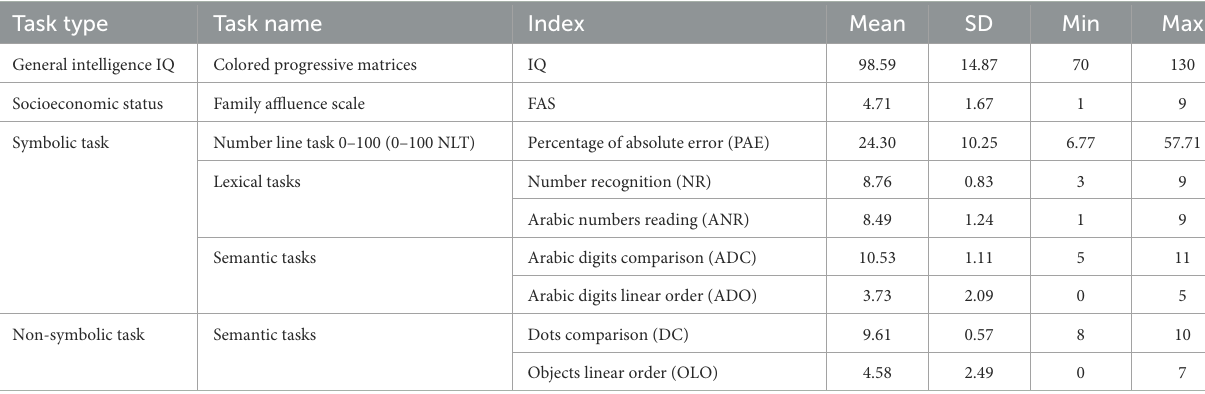
TABLE 1 Descriptive statistics of all variables ( n = 92).